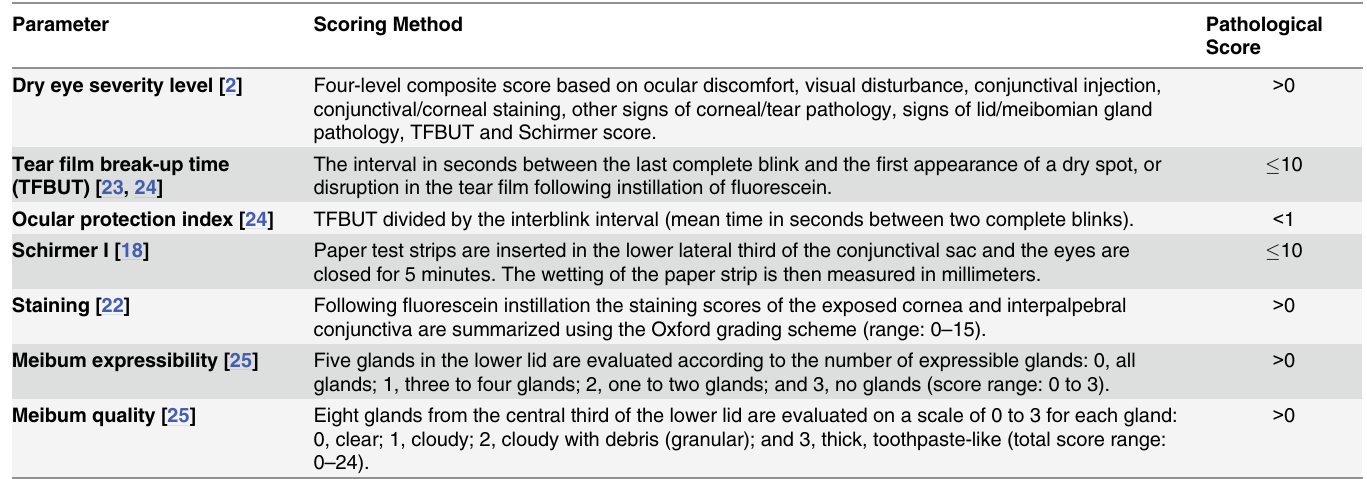
Table 1. Ophthalmological Work-up.